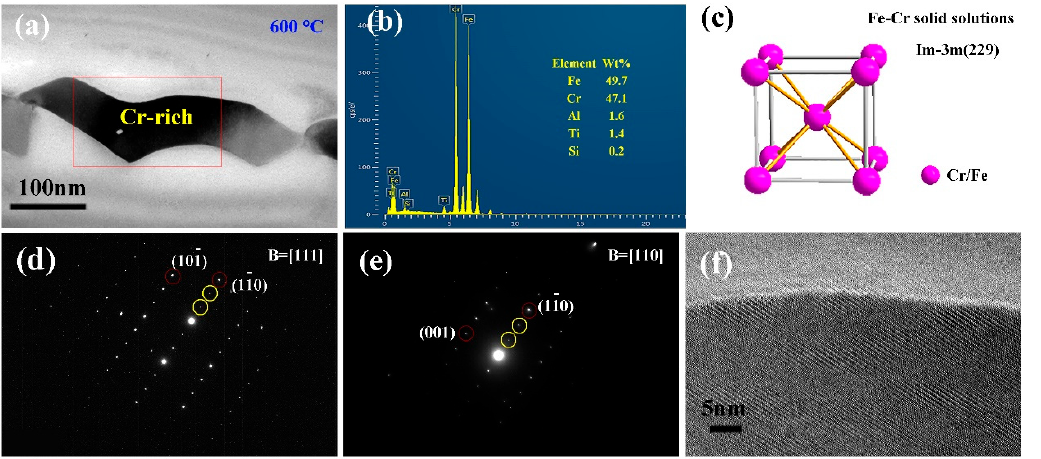
Figure 7. ( a ): Typical TEM-BF image of the Cr-rich precipitate along the grain boundary in the annealed Fe-25Cr-5Al-RE wire rod at 600 °C, where a hole was formed because of irradiation by the converged incident electron beam. ( b ): EDS results from the area around the hole in ( a ). ( c ): The constructed α′ phase lattice. ( d , e ): Indexing the SAED patterns from the precipitates along the grain boundary. ( f ): High-resolution TEM images of the precipitate in the rectangle in ( a ) along [110] axis.